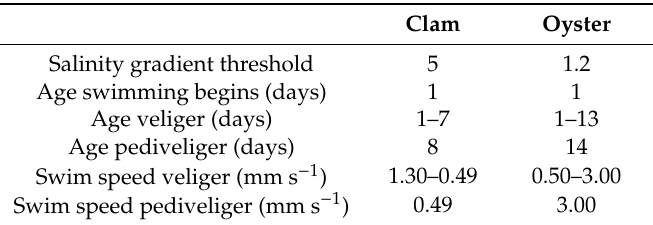
Table 1. Parameterized behavior used in LTRANS to define both clam and oyster response to the environment in the model. Salinity gradient threshold (max vertical salinity gradient over 1 m) that cues larval behavior, age swimming begins, age of veliger stages, age of pediveliger stages, and swimming speeds at veliger and pediveliger stages for both clam and oyster sub-behaviors in the